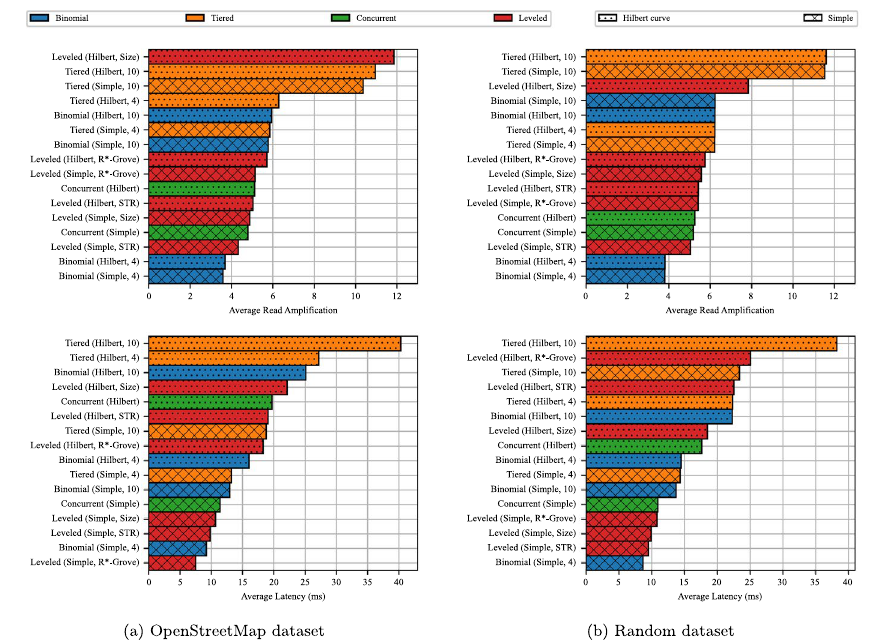
Fig. 13 Average read amplification and latency for selectivity 10 −